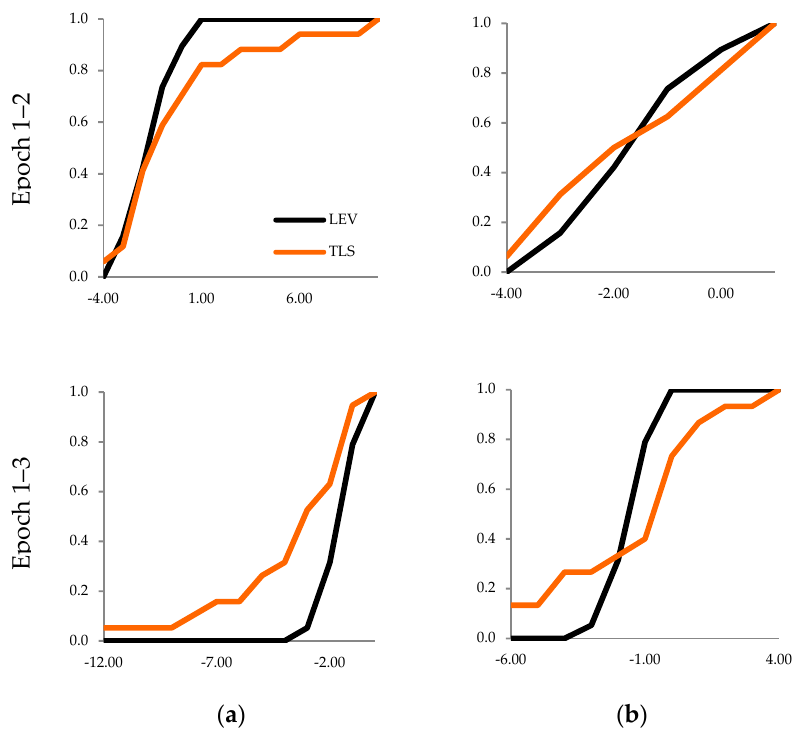
Figure 6. Distribution of vertical displacements TLS vs. LEV; OX axis: Clusters, OY axis: Distribution of displacements; ( a ) Second set of input data, ( b ) Third set of input data.